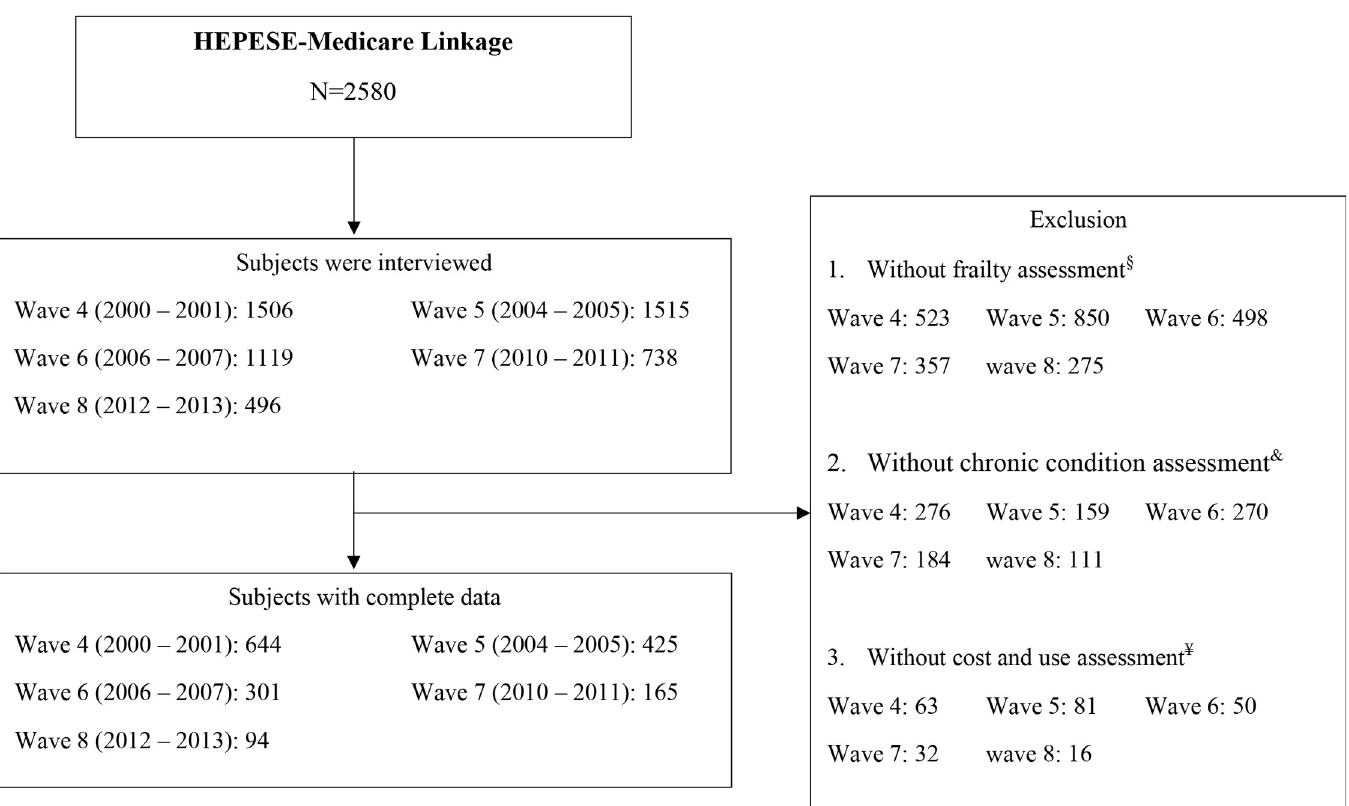
Fig 1. Flowchart of cohort selection. § Modified five criteria frailty assessment. & The Chronic Conditions (CC) segment of the Master Beneficiary Summary File (MBSF) was used to define chronic conditions; MBSF-CC files in 2001, 2005, 2007, 2011, and 2013 were used for wave 4, 5, 6, 7 and 8 separately; a list of the 37 conditions included in the study is presented in the Supporting Information S1 Table. ¥ The cost and use segment of MBSF files in 2002, 2006, 2008, 2012, and 2014 were used for wave 4, 5, 6, 7 and 8